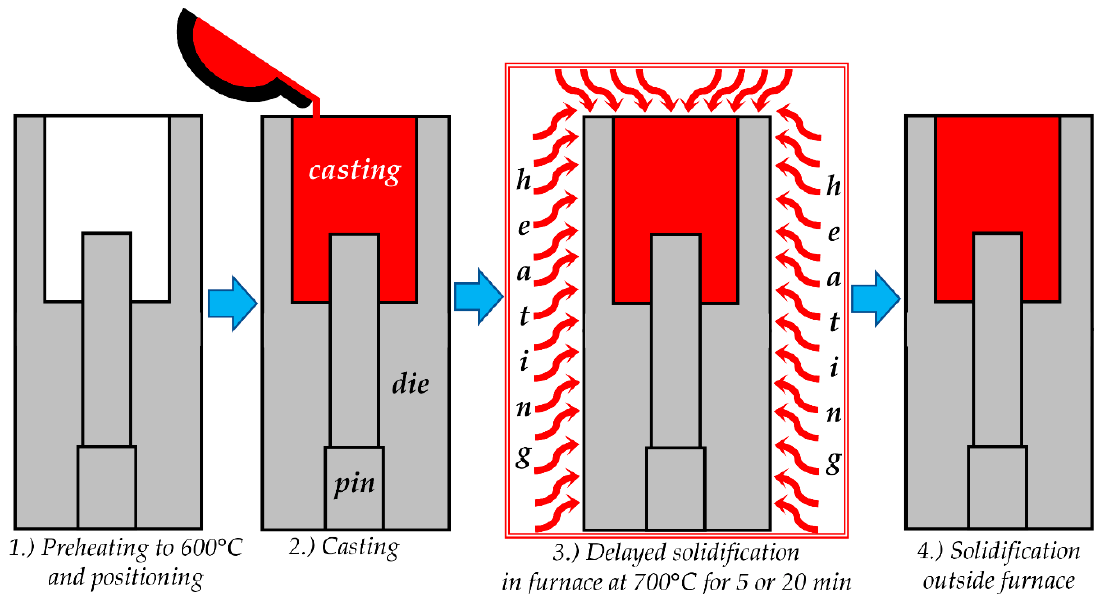
Figure 1. Schematic illustration of the casting method with the delayed solidification.